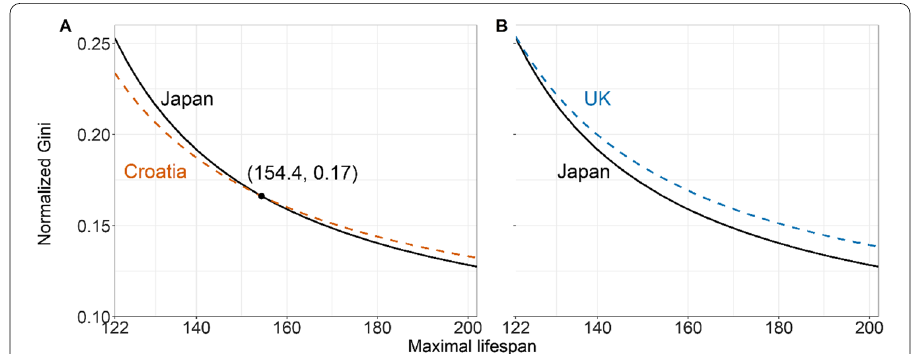
Fig. 2 Normalized Gini with changing value of maximal lifespan (horizontal axis), Japanese females vs. Croatian females in 2015 ( A ), and Japanese females vs. UK females in 2015 ( B ) (Source: Authors’ elaboration based on the HMD